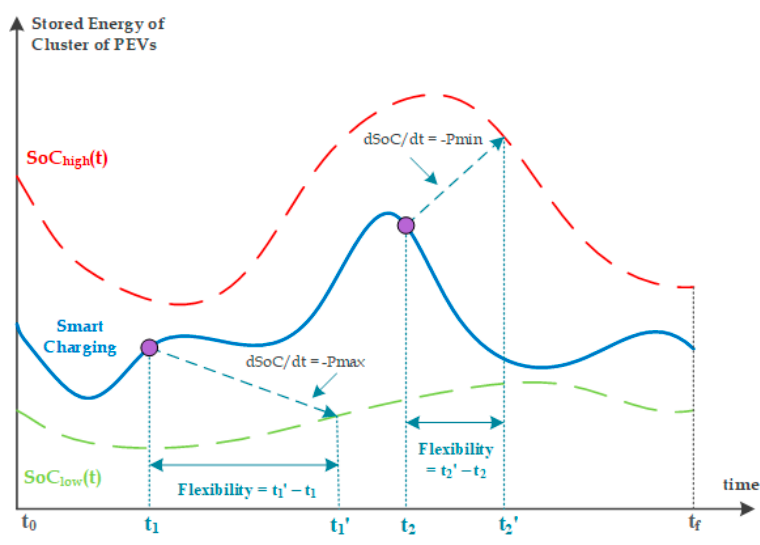
Figure 4. Flexibility of a CPEV/A to adjust its active power.